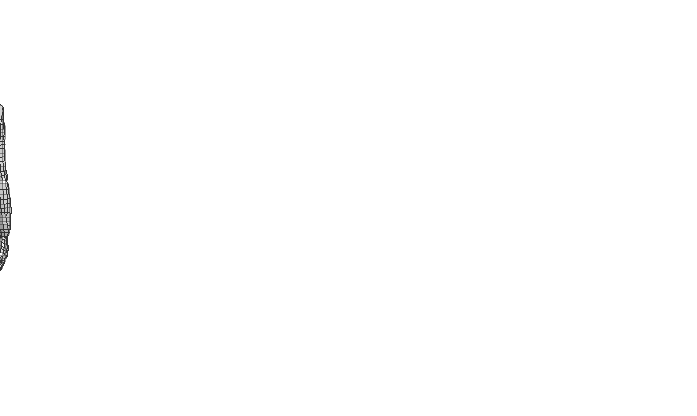
Figure 9. Subject-specific Czech child model. Female, 6 y, 118 cm, 19 kg. Front ( left ), side ( middle ), and back ( right ) views.